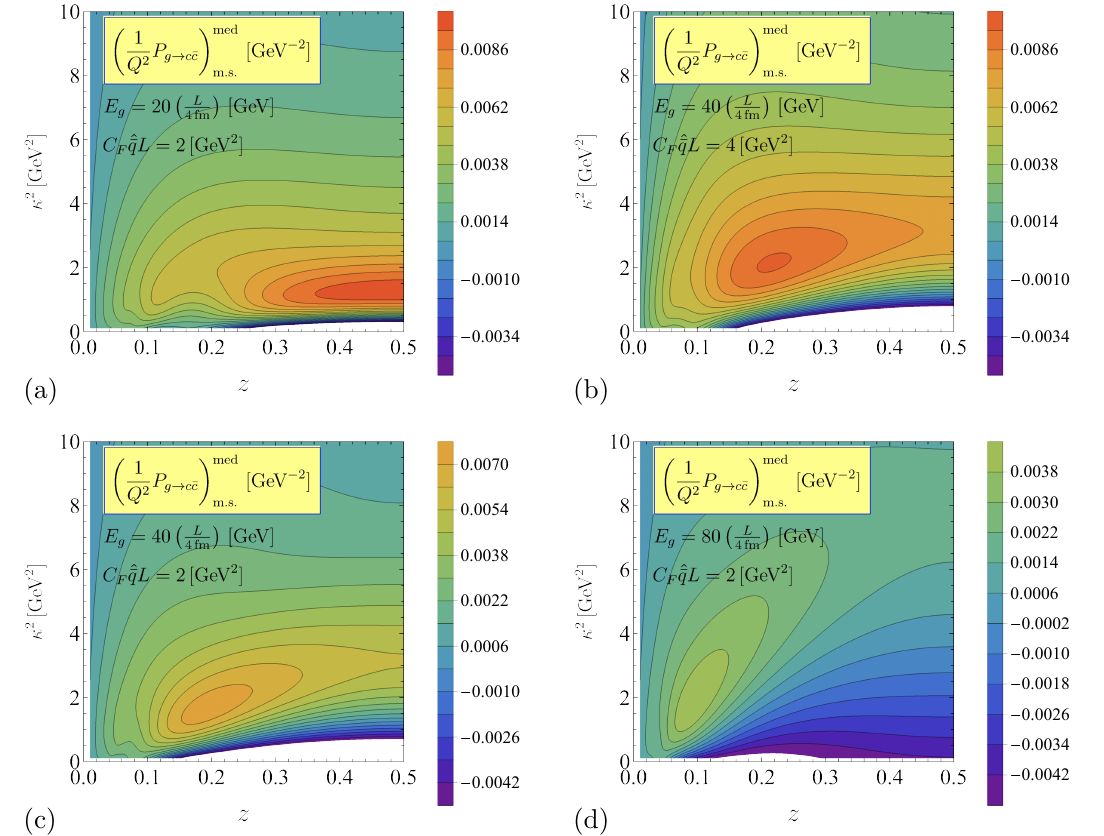
Figure 7 . The medium-modified g → c ¯ c splitting function evaluated in the saddle point approxima- tion (4.10)–(4.13). (a) is the same as figure 6(b). Different panels show results for different values of the typical momentum squared ˆ qL transferred from the medium and for different gluon energies E